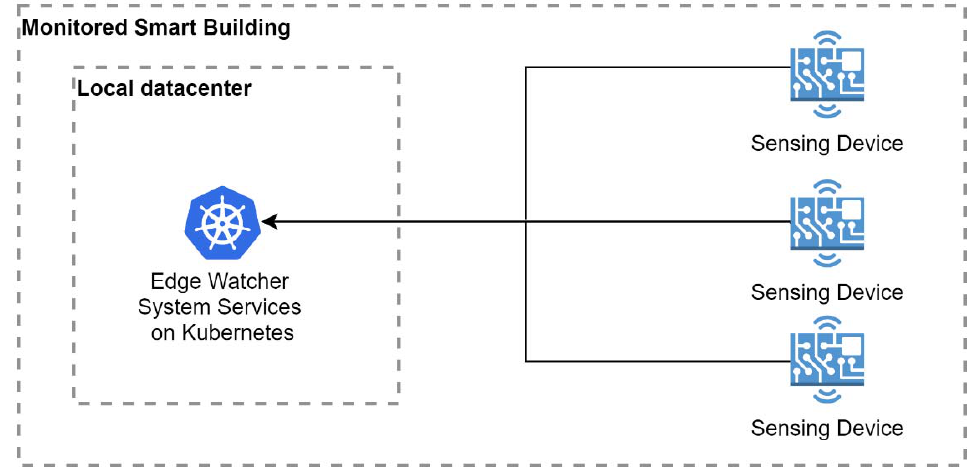
Figure 2. EWS with a local datacenter Kubernetes cluster.